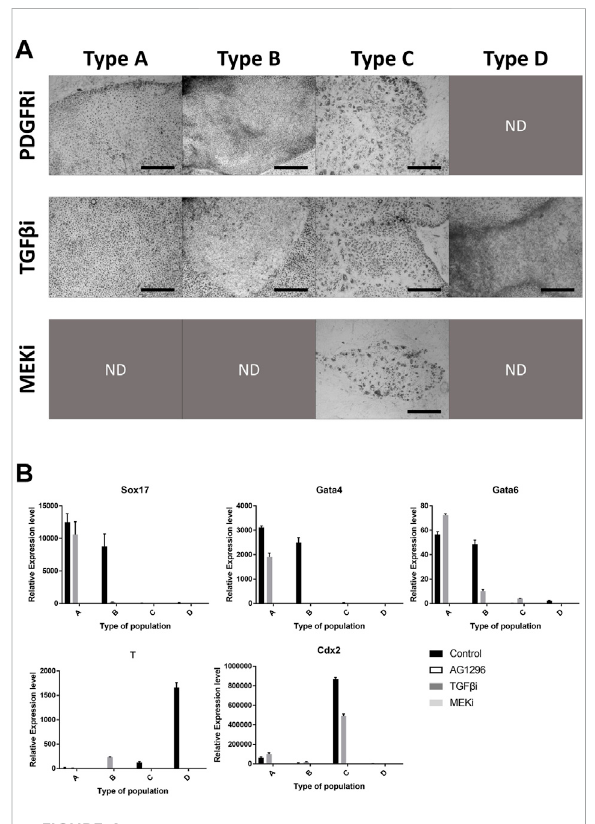
FIGURE 4 Effects of signaling inhibitors on the four types of cells. (A) Morphology of each cell type with inhibitor-treated cell types. Images were collected from Figure 5. (B) Expression patterns of marker genes in cell types with inhibitor treatment. All scale bars are 100 μ m. Different letters show signi fi cant differences among samples. (PDGFRi, platelet-derived growth factor receptor inhibitor; TGF β i, transforming growth factor β inhibitor; MEKi, mitogen-activated protein kinase inhibitor; ND, not